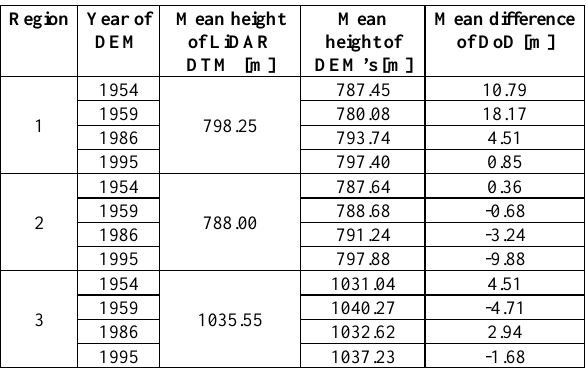
Figure 5. Regions where comparing the photogrammetric DEM’s to the LiDAR DTM.